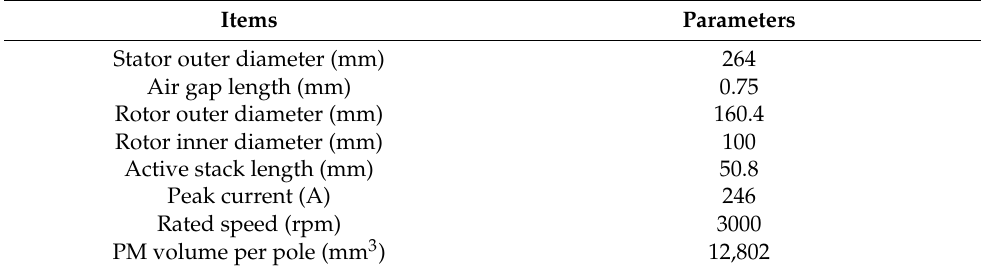
Figure 1. Machine configurations. ( a ) The Prius 2010 machine. ( b ) The MAS-IPM machine. Table 1. Key common design parameters of Prius 2010 IPM and Mas-IPM